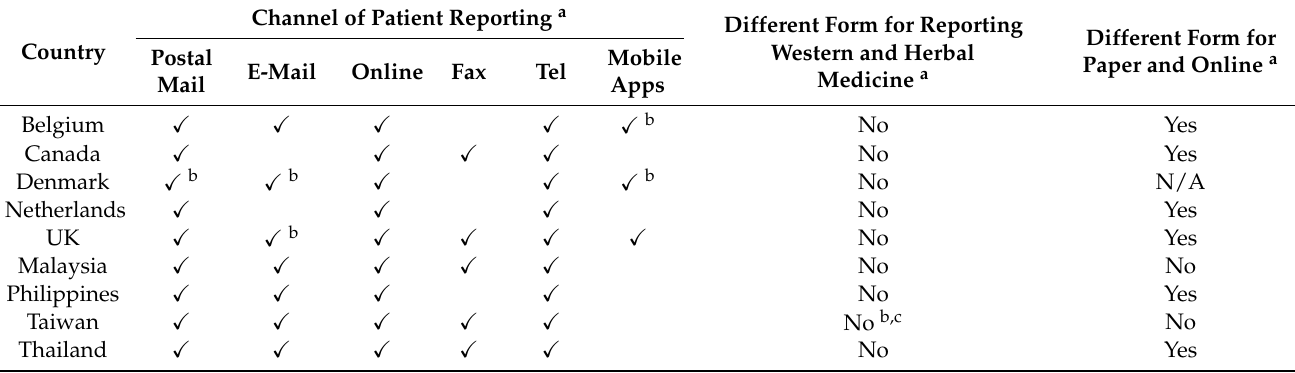
Table 3. Characteristics of channel and form of patient reporting.